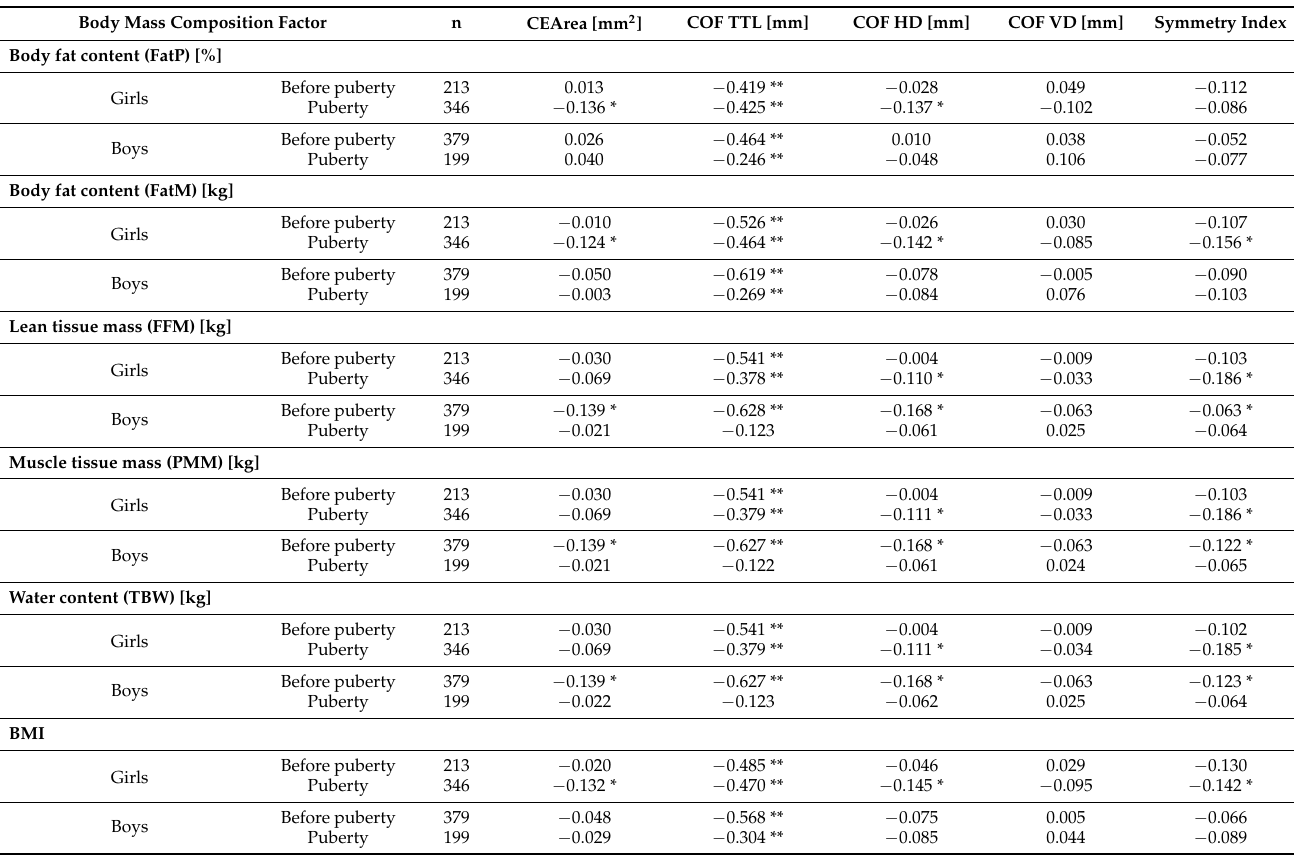
Table 4. Correlation between body mass composition, BMI and gender balance parameters (Rho